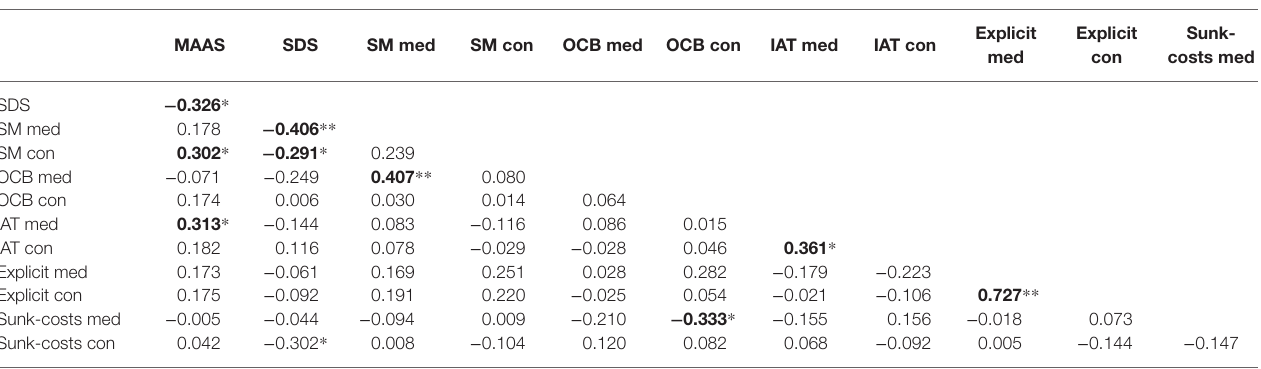
TABLE 2 | Associations between measures in Study